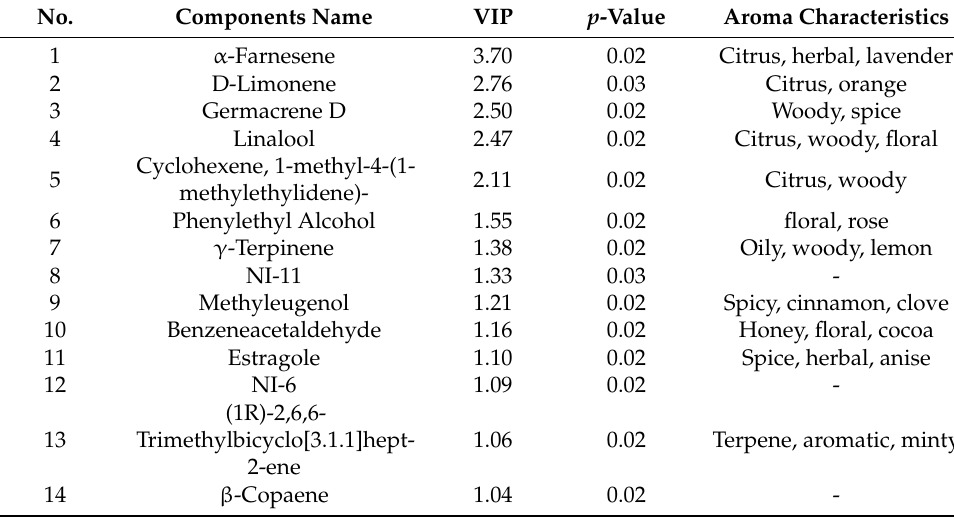
Table 3. Characteristics of the 14 crucial components in the PLS-DA